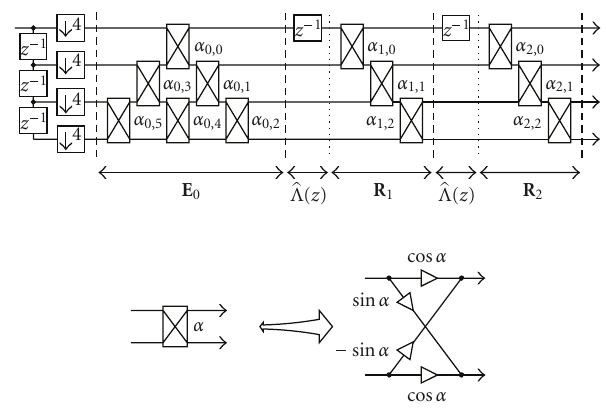
Figure 1: Conventional plane rotation-based lattice structure for 4-channel general PUFB ( N =